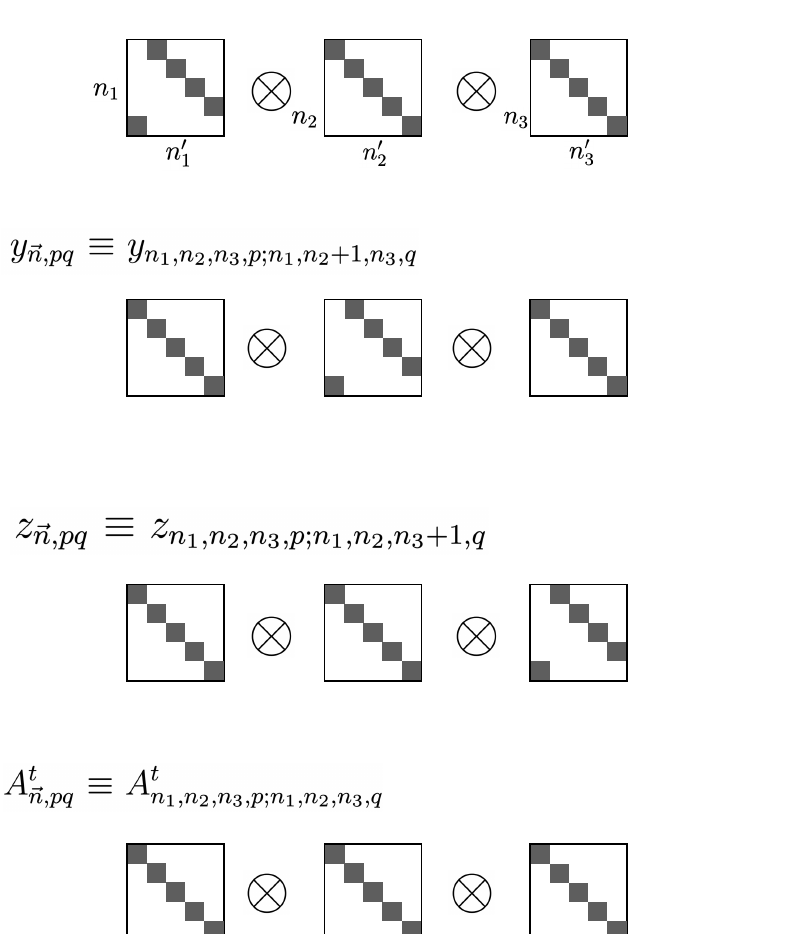
Figure 1 . Schematic picture of the embedding of the orbifold lattice in large matrices. Nonzero components (A.10) are shown in